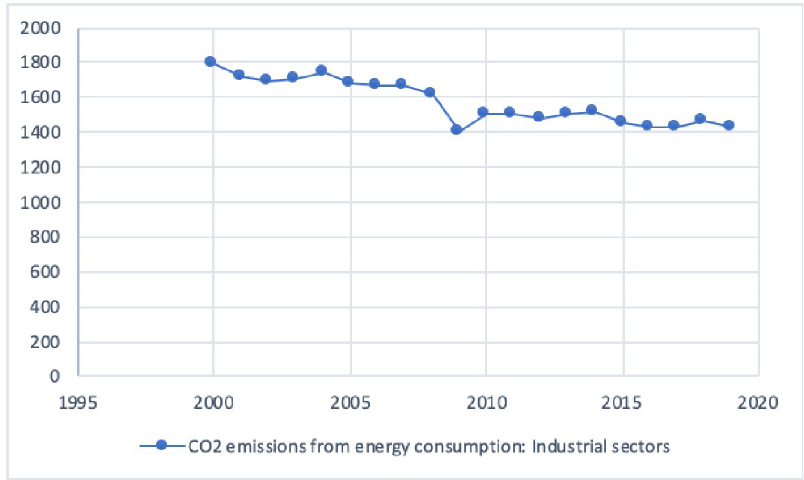
Fig 8. CO2 emission industrial sectors (a million